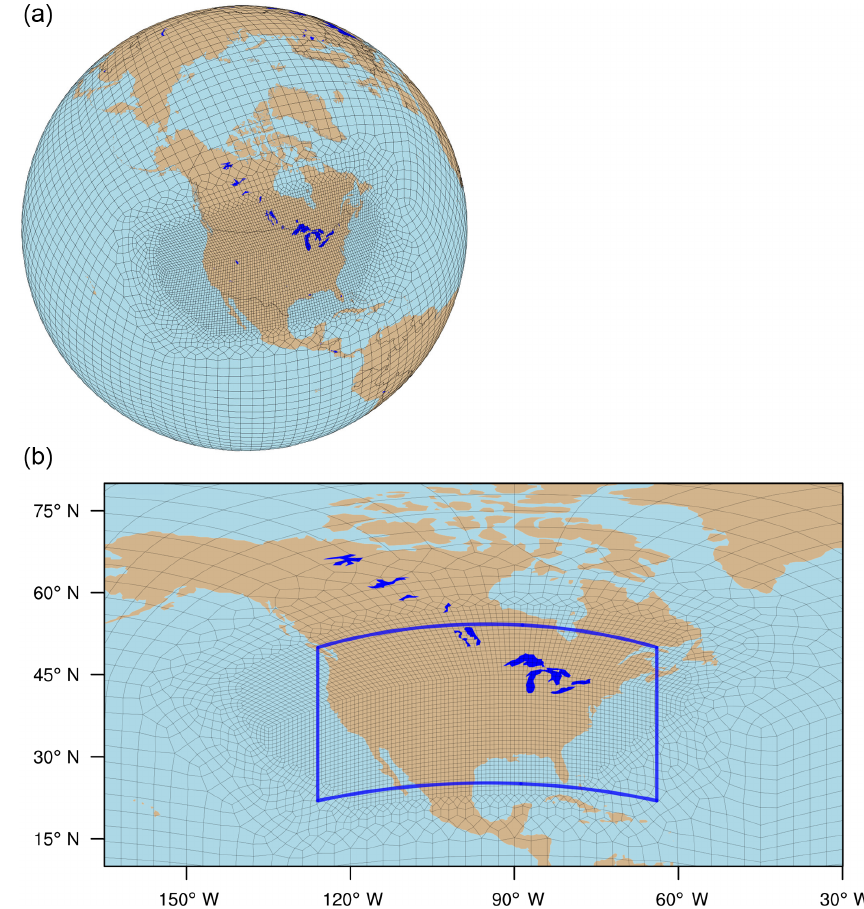
Figure 1. The CONUS regionally refined grid in (a) a global orthographic projection and (b) a cylindrical equidistant projection zoomed in over the high-resolution (HR) portion. The effective resolutions for the low-resolution (LR) and the HR regions are 1 and 0.25 ◦ , respectively. The two regions are connected with a transient area. The blue box (latitude range: 22–50 ◦ N, longitude range: 64–126 ◦ W) in panel (b) represents the analyzed area for CONUS. Table 1. List of EAMv1 simulation configurations, speed, and costs. The speed and cost are for the NERSC Cori-KNL machine. SYPD: simulation year per